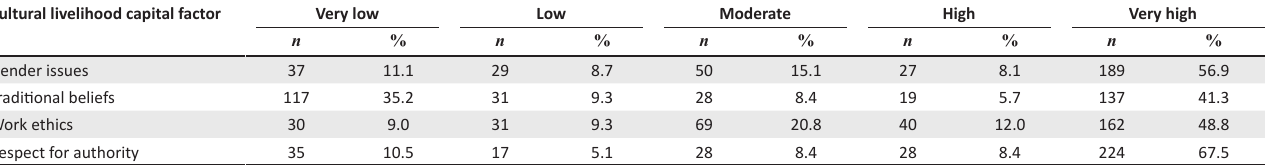
TABLE 8: Ratings of the cultural livelihood capital factors ( n = 332). Cultural livelihood capital factor